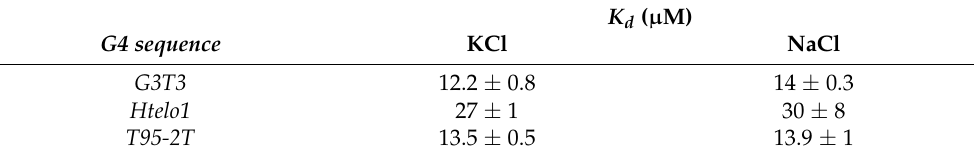
Table 1. K d values calculated for each oligonucleotide strand in the presence of Rhau25